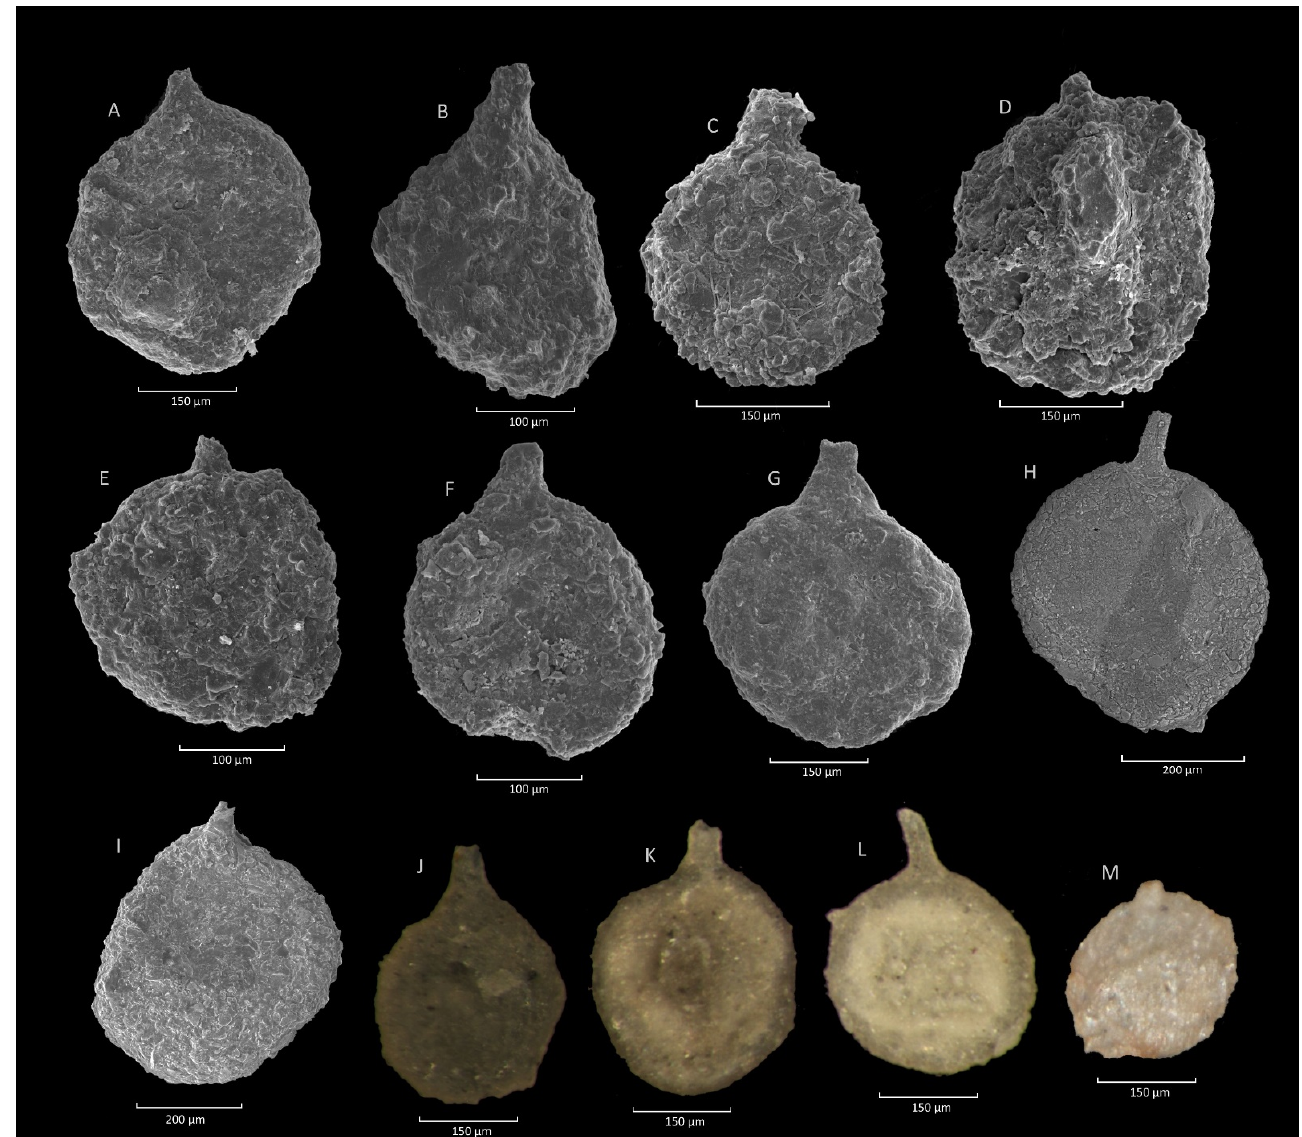
Figure 8. Saccammina grzybowskii (Schubert) type group. ( A ): Gorze ń section; ( B ): Jaworzynka section; ( C – E ): Krzes ł awice section; ( F ): Mutne section; ( G ): Rzyczki section; ( H , I ): Ropica section; ( J ): Jaworzynka section; ( K,L ): Ropica section; ( M ): Olecka section.